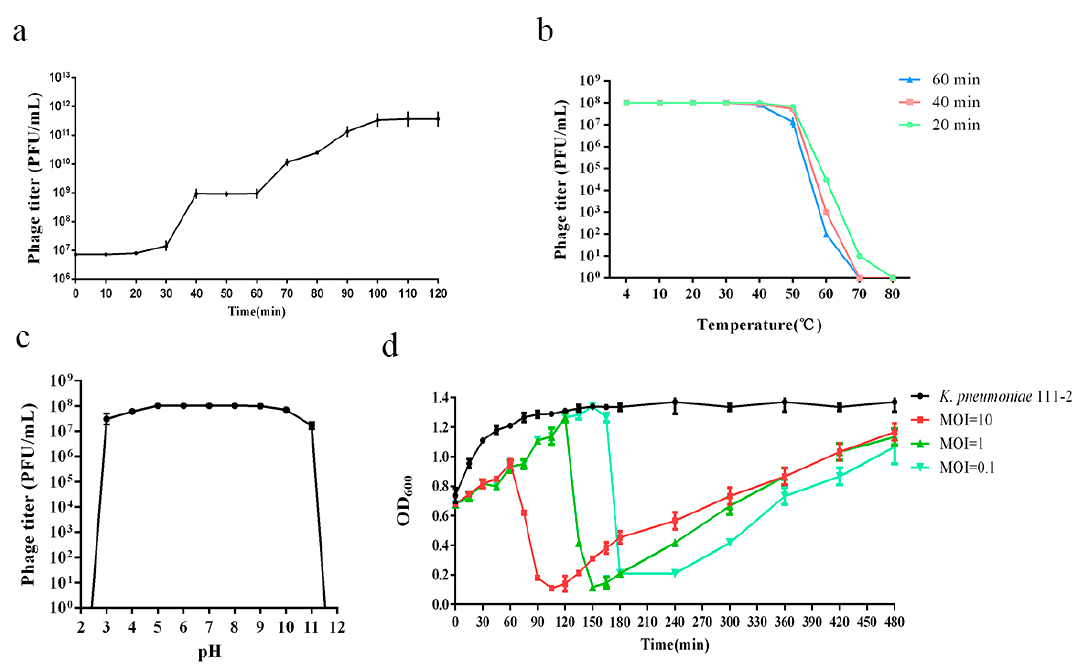
Figure 2. Biological characteristics of phage vB_KpnP_ZX1: ( a ) one-step growth curve; ( b ) thermal stability; ( c ) pH stability; ( d ) phage bactericidal curve.